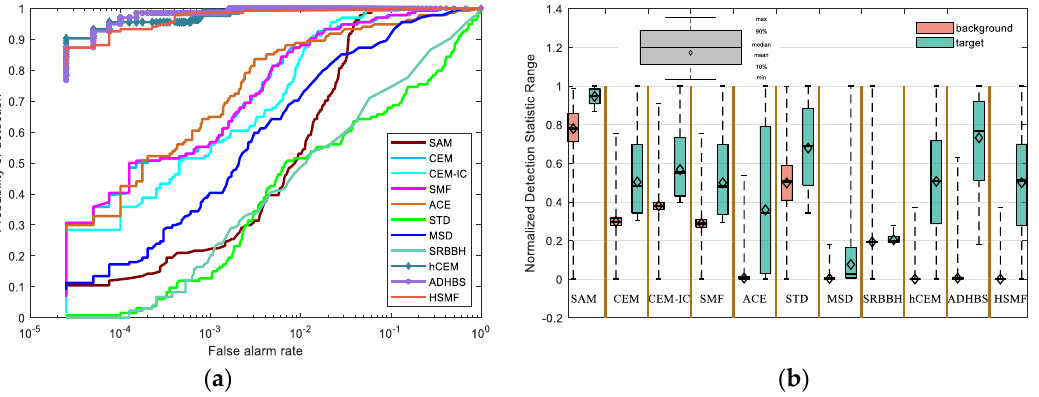
Figure 4. ( a ) The receiver operating characteristic (ROC) curves of different detectors on the San Diego Airport data. ( b ) The separability map of all detectors for the San Diego Airport data.